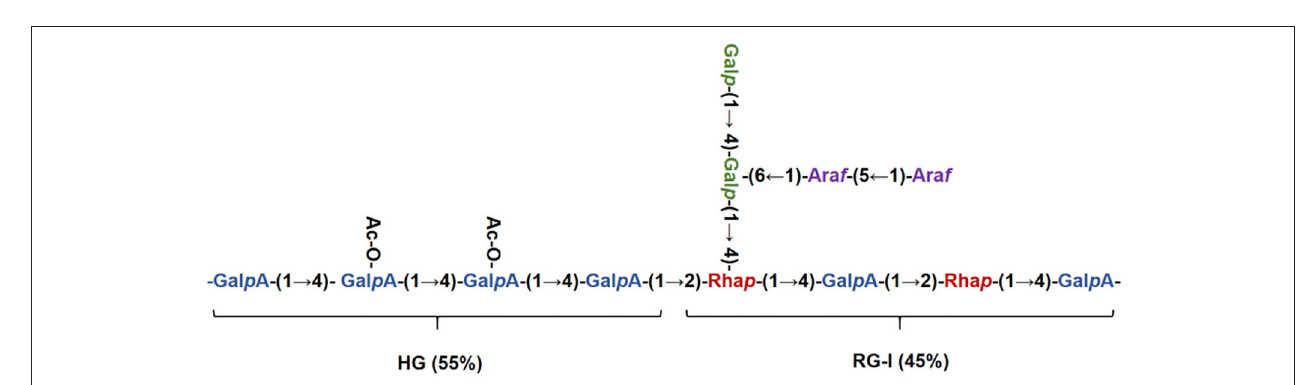
then incubated with LPS. For high concentration (200 µ g/mL) p < 0.01, medium concentration (100 µ g/mL) p < 0.01 and low concentration (50 µ g/mL) p < 0.05, different dose groups could reduce cellular NO secretion ( Supplementary Figure S3